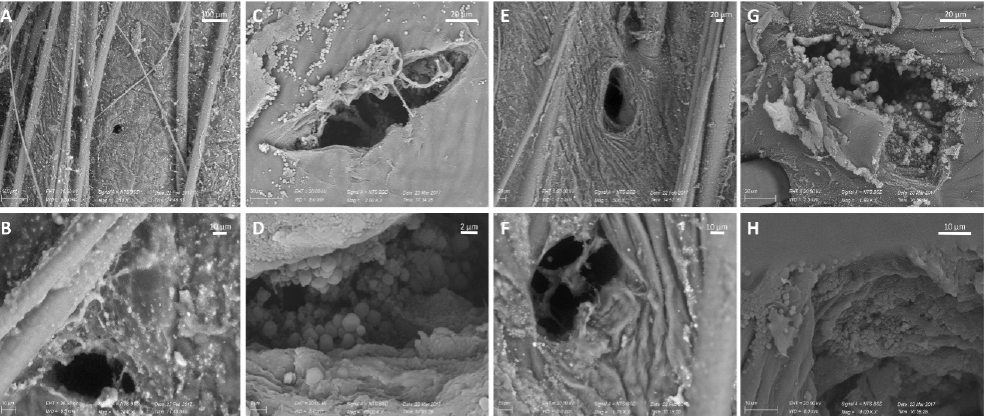
Figure 4. SEM visualization of DCF nanosuspensions (NST80) on the skin after microneedle rolling in four directions with the DermaQ ® with needle lengths of 0.5 mm ( A – D ) or 1.5 mm ( E – H ). Images were acquired in LV mode ( A , B , E , F ) or HV mode ( C , D , G , H ).